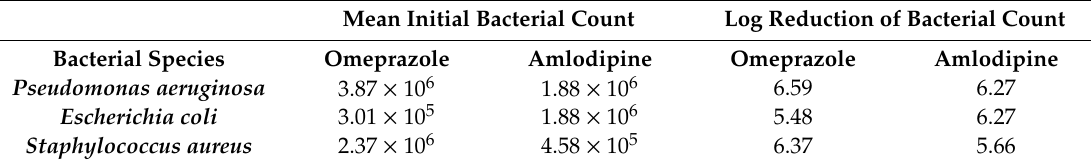
Table 3. The initial bacterial challenge in the formulations of omeprazole and amlodipine and the log reduction of bacterial load over the 28-day